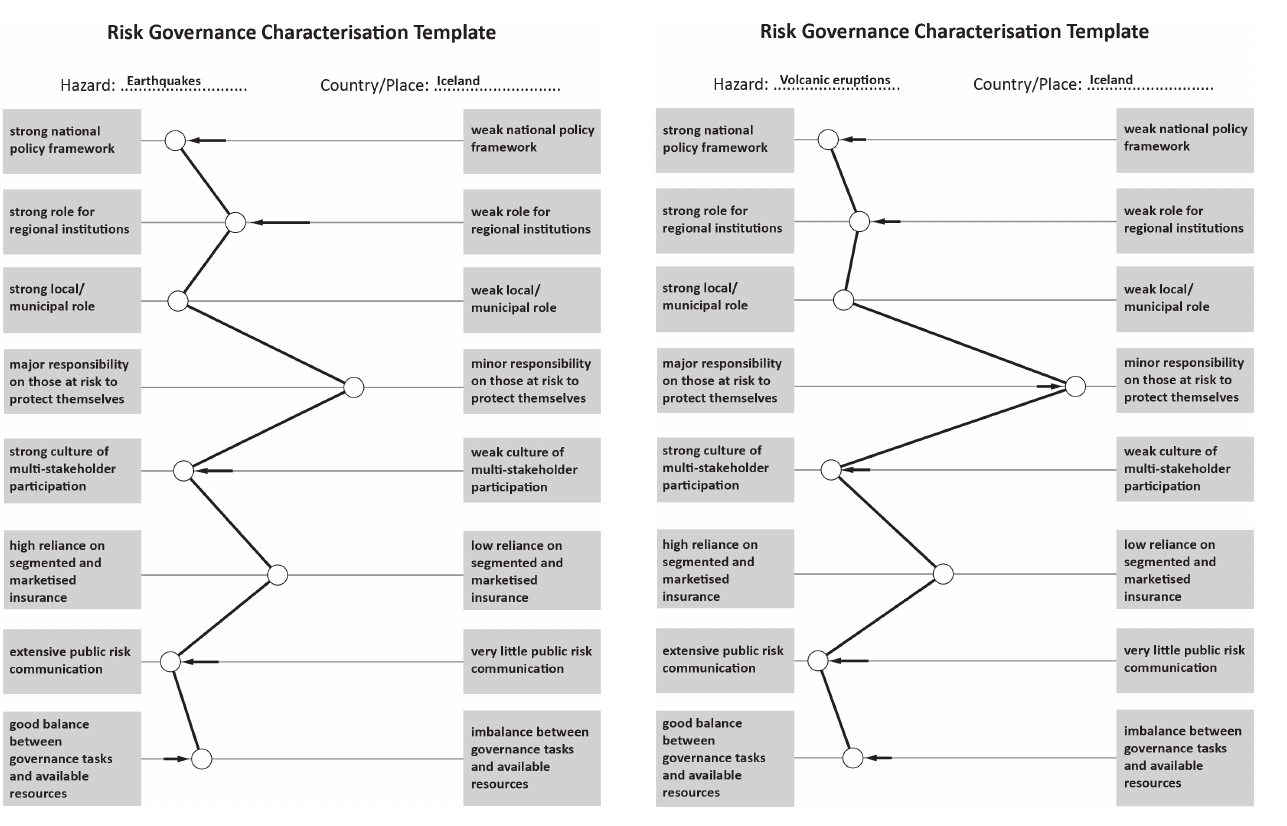
Fig. 2. Example of risk governance profile – Earthquakes in Iceland. Fig. 3. Example of risk governance profile – Volcanic eruptions in